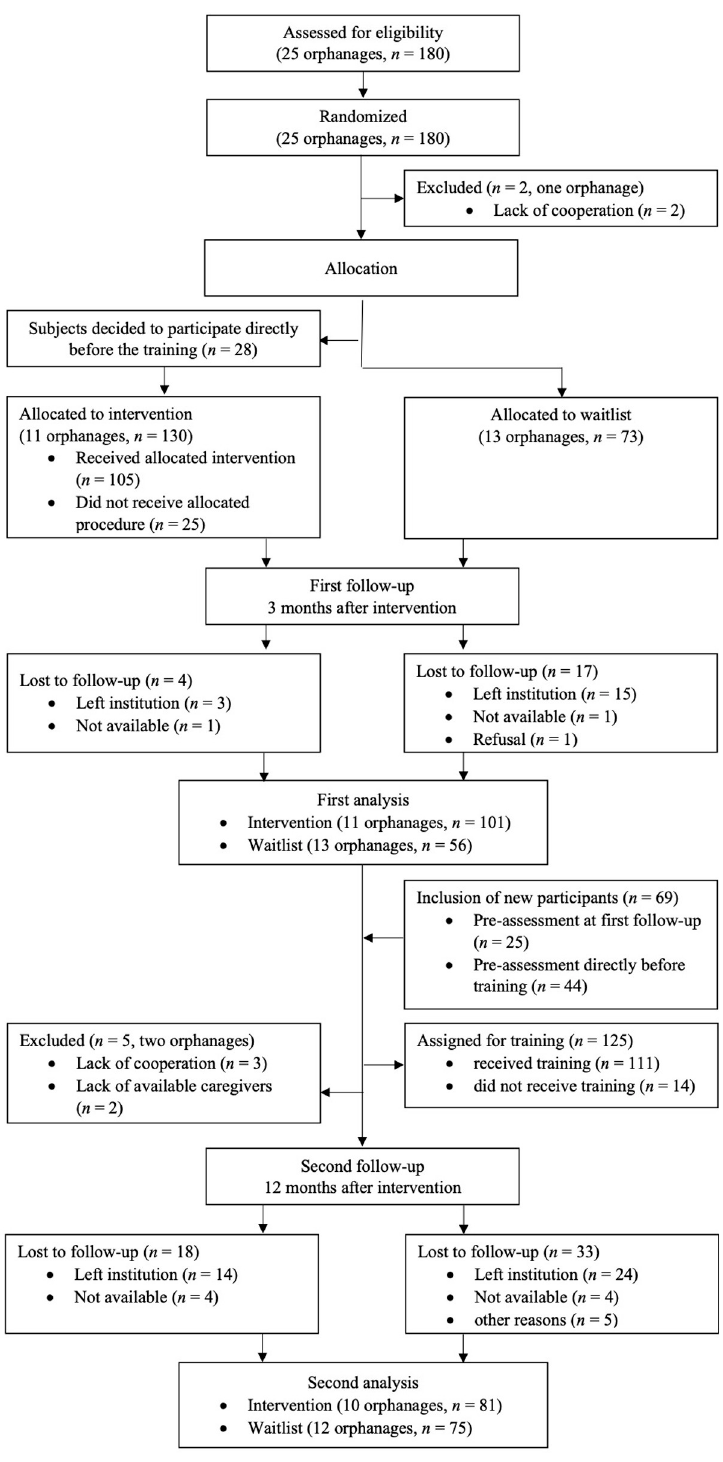
Fig 1. Participant flow